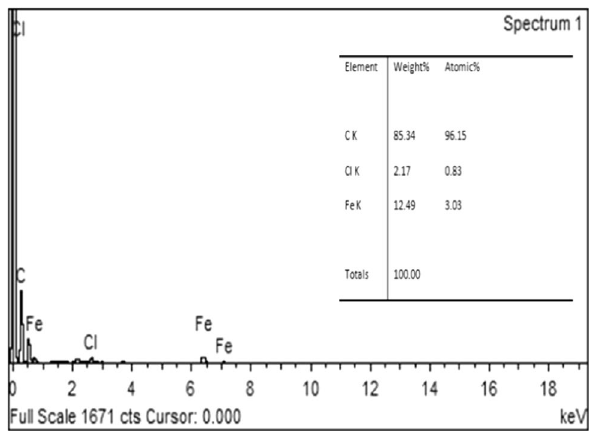
Fig. 5 XRD curve for Fe-AIB